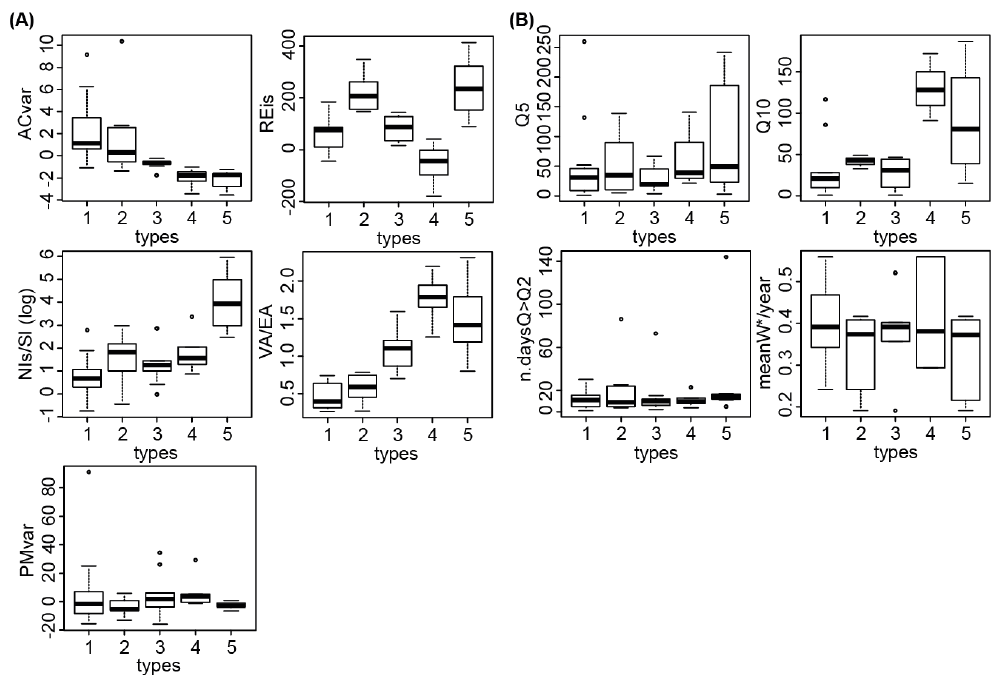
Fig. 5. (A) The characteristics of the five clusters resulted from the hierarchical classification analysis performed on the landscape variables (based on the two first component of the PCA in Fig. 4). Landscape variables acronyms are listed in Table 2. (B) The hydrological and morphological characteristics of clusters: Q 5 = number of months since the last Q 5 ; Q 10 = number of months since the last Q 10 ; n.daysQ>Q 2 = number of days at which water flow exceeded Q 2 discharge; meanW*/year = sediment regime.